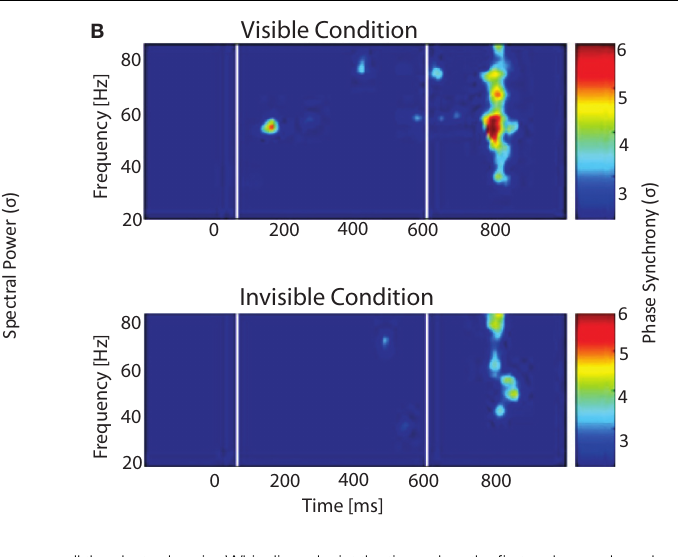
all the electrode pairs. White lines depict the time when the fi rst and second word were presented. Color scale corresponds to amplitude expressed in SD, calculated over a 500-ms baseline. (A) Time-frequency plot: Two increments in gamma oscillations are visible. The fi rst, only present in the visible condition, the second